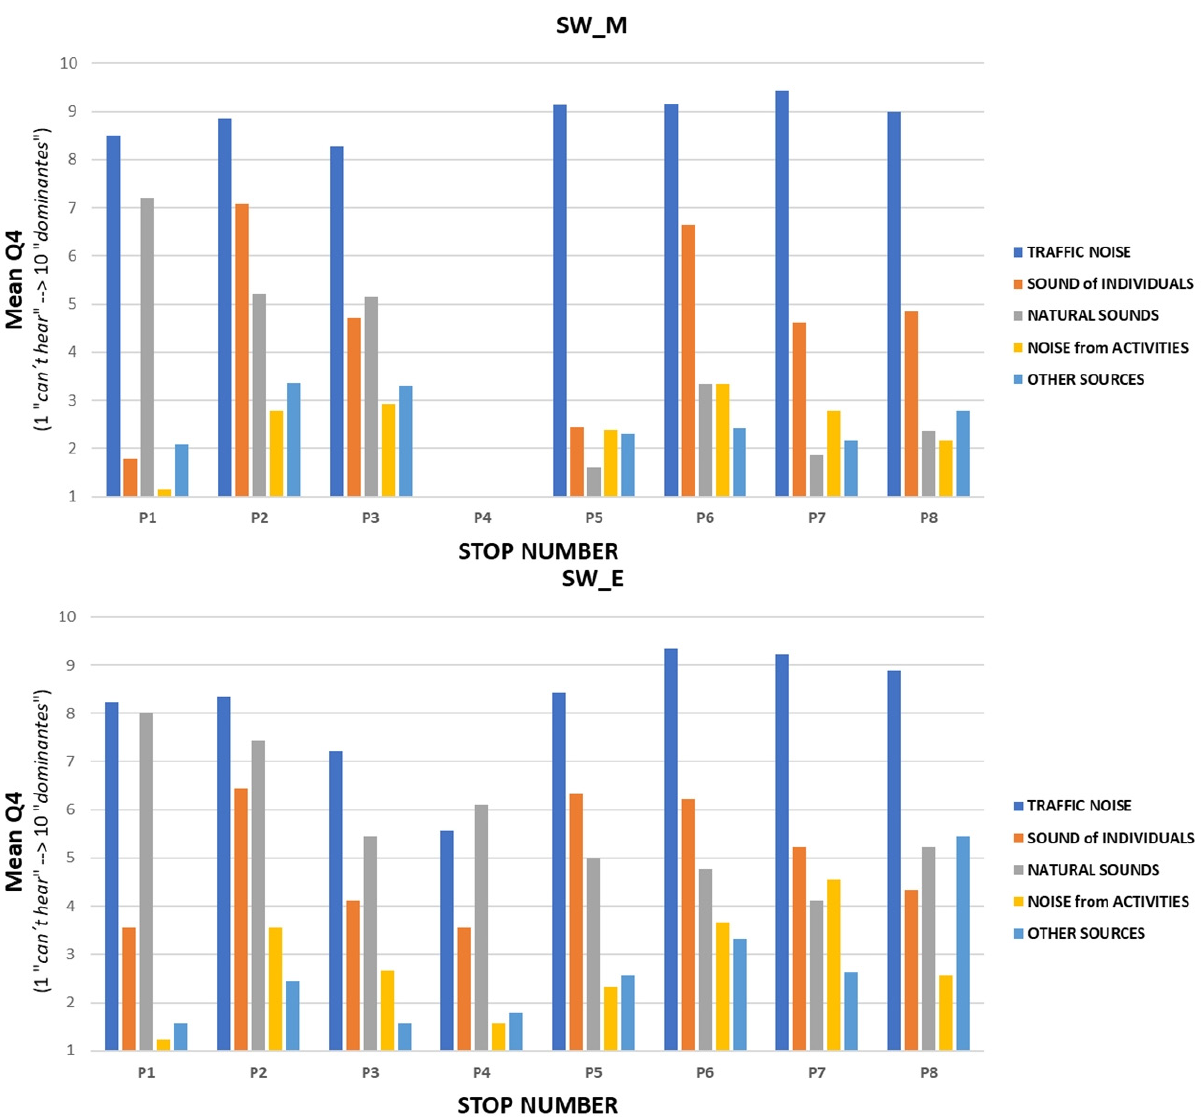
Figure 11: Environmental sound dominance for SW_M (top) and SW_E